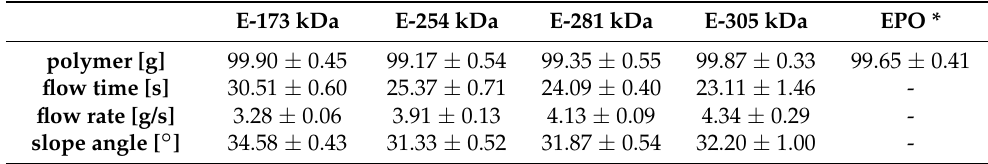
Table 4. Flowability data of ModE considering different molecular weights (M w ) and EPO. Each value designates the mean ± S.D. (n = 3). E-173 kDa E-254 kDa E-281 kDa E-305 kDa EPO * polymer [g] 99.90 ±